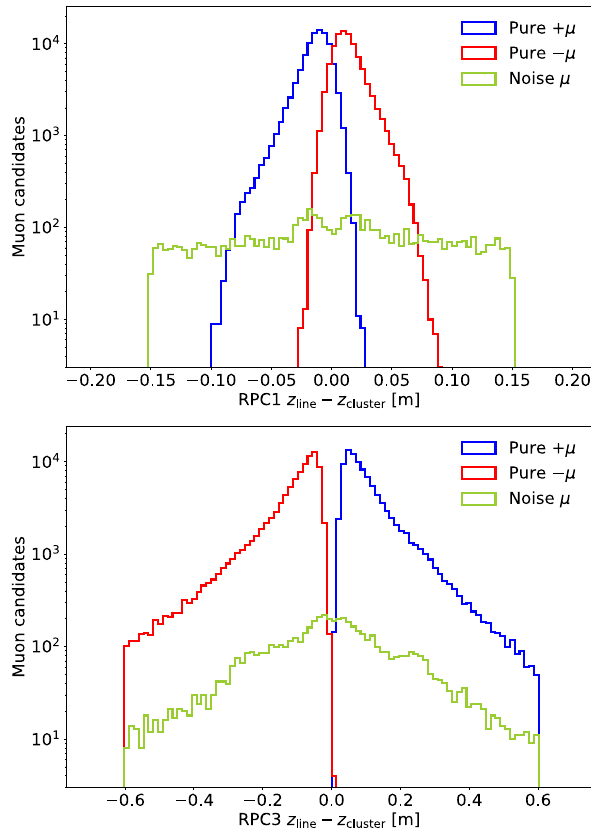
Fig. 3 Differences of z coordinates between the impact point of the seed line and the cluster position in the RPC1 (top) and RPC3 (bottom) layers. Positively charged muon candidates are shown in blue and neg- atively charged muon are shown in red. Muon candidates that include a noise cluster are shown in green